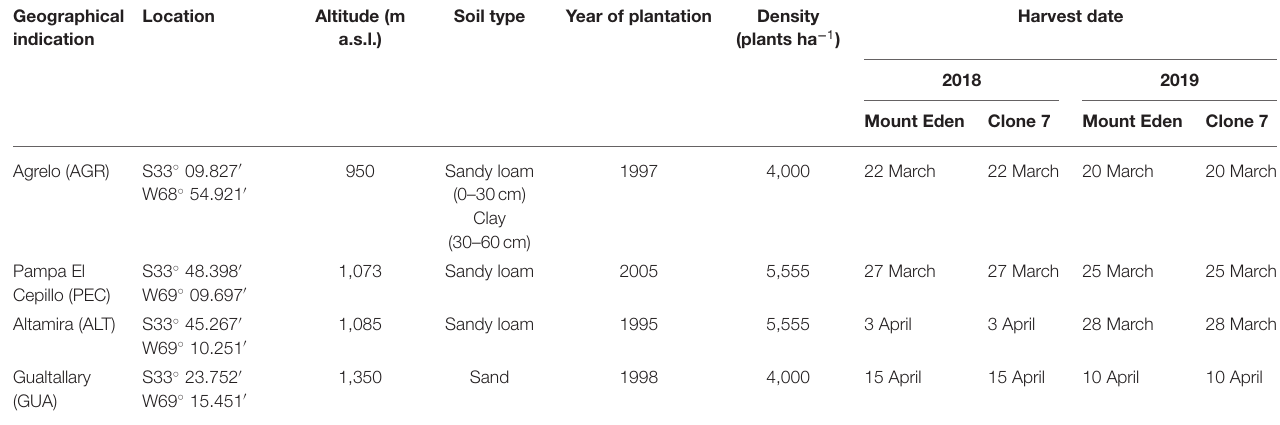
TABLE 1 | Description of the Cabernet Sauvignon vineyards. Geographical